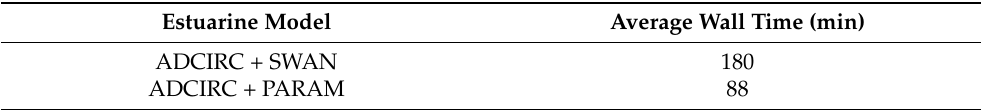
Table 1. Wall clock time for each of the MMEMS estuarine simulations. The ADCIRC + PARAM wall clock time is 51% shorter than the ADCIRC + SWAN.